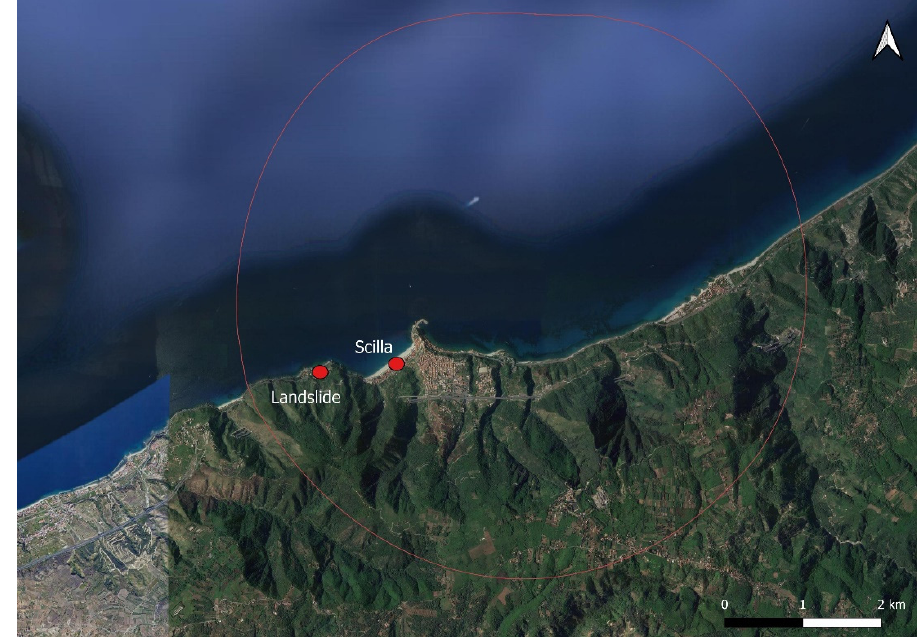
Figure 16. QGIS shapefile representing domain boundaries (red circle).